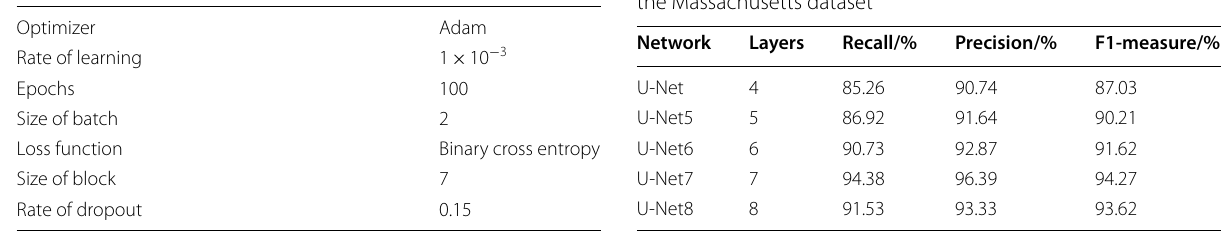
Table 4 Results comparison of dissimilar deep network trials